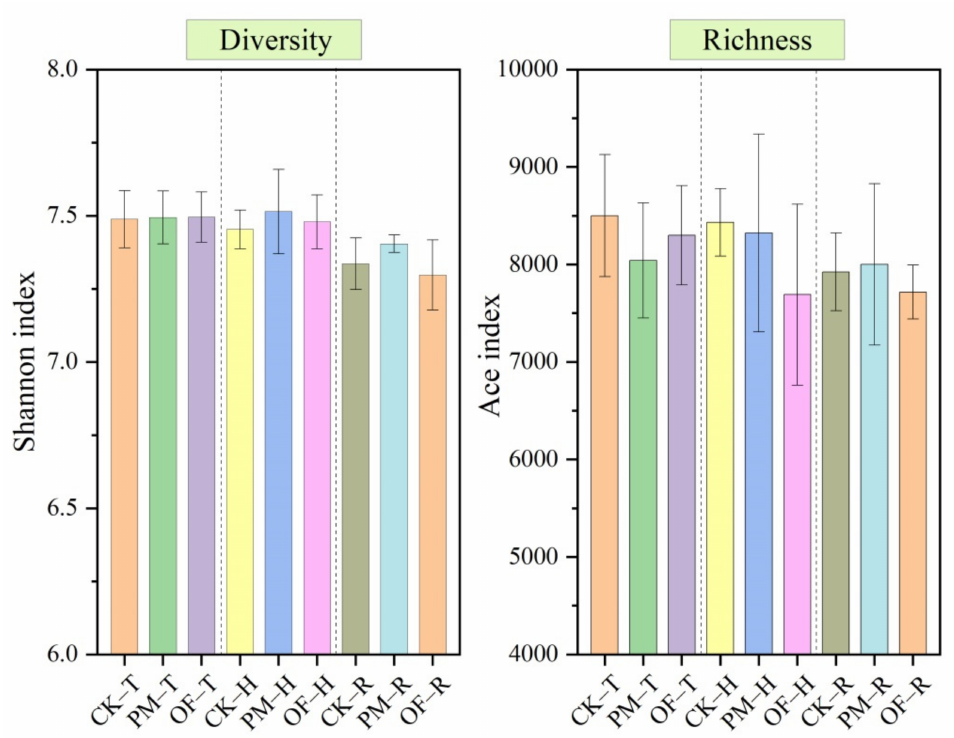
Figure 2. The Shannon and Ace indexes of microbial community with different